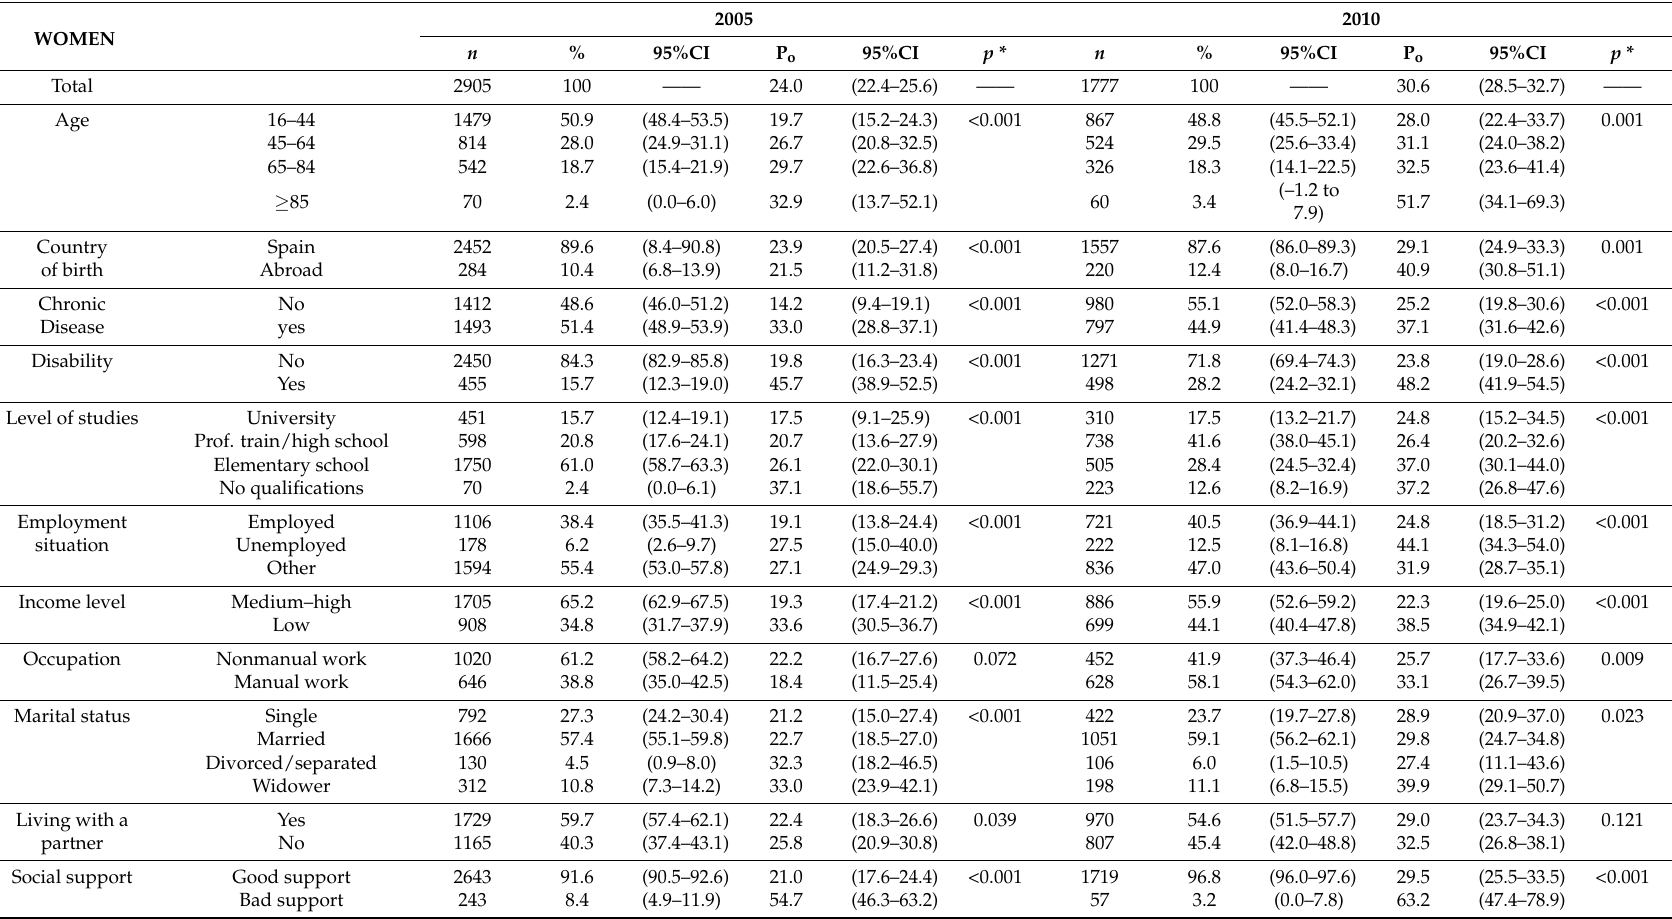
Table 2. Frequencies ( n ), percentages (%) of population distribution, and observed prevalence (P o ) × 100 and 95% confidence interval (95%CI) of the risk of poor mental health, according to categories of explanatory variables and according to the year of the survey.